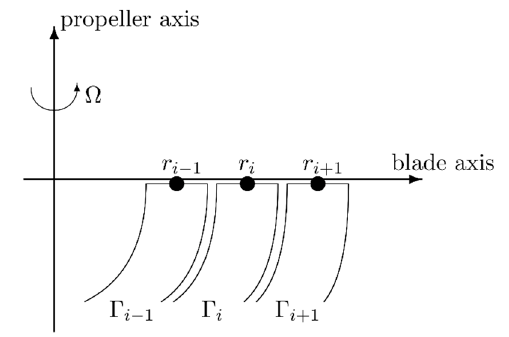
Figure A2. Illustration of the vortex system on the propeller blade.